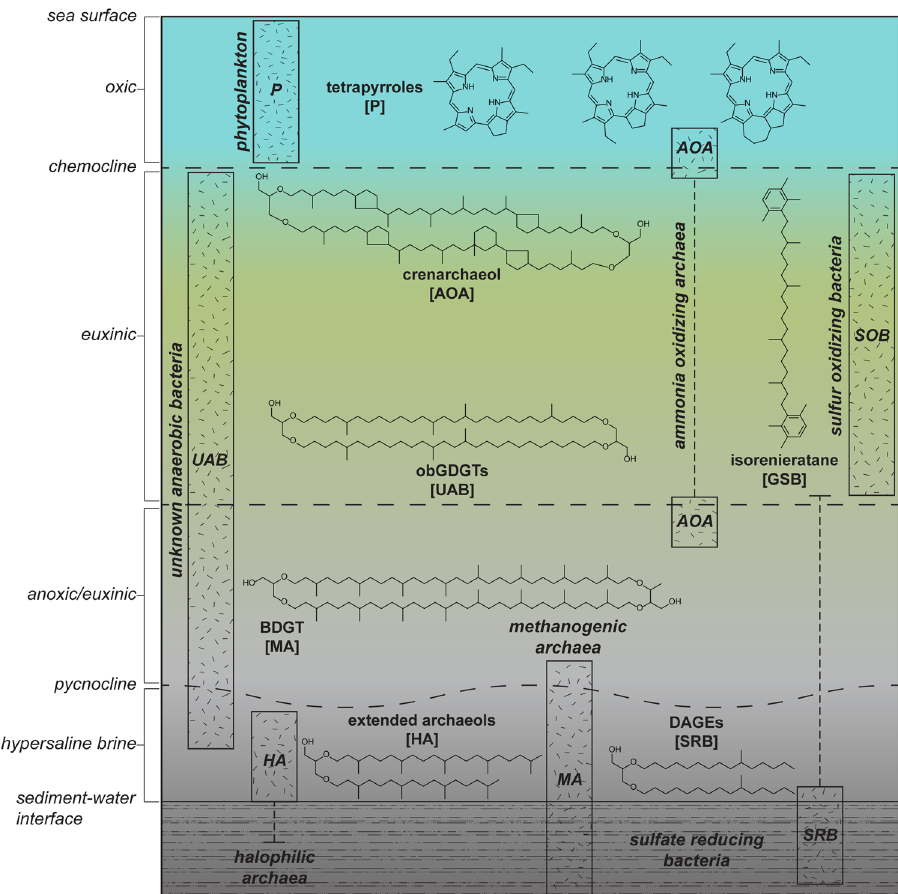
Fig. 2 An idealized 2-D water column portraying the depth distribution and source organisms of biomarkers detected in mid-Cretaceous strata from Site 1258, Demerara Rise. The residence depths of speci fi c microbes are illustrated using rectangles, spanning habitable depth ranges, and containing relevant abbreviations (e.g., sulfur-oxidizing bacteria = SOB). Vertical hashed lines represent regions potentially occupied by a speci fi c organism but beyond their ideal depth range. Selected biomarker structures are depicted to portray the compound diversity hosted in sediments from the Demerara Rise, with the source organism abbreviation in